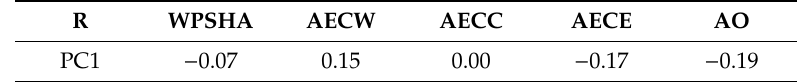
Table 6. Correlation coe ffi cients (R) between PC1 and the Atmospheric circulation indices-based predictors (bold font indicates statistically significant values at the 5% level).